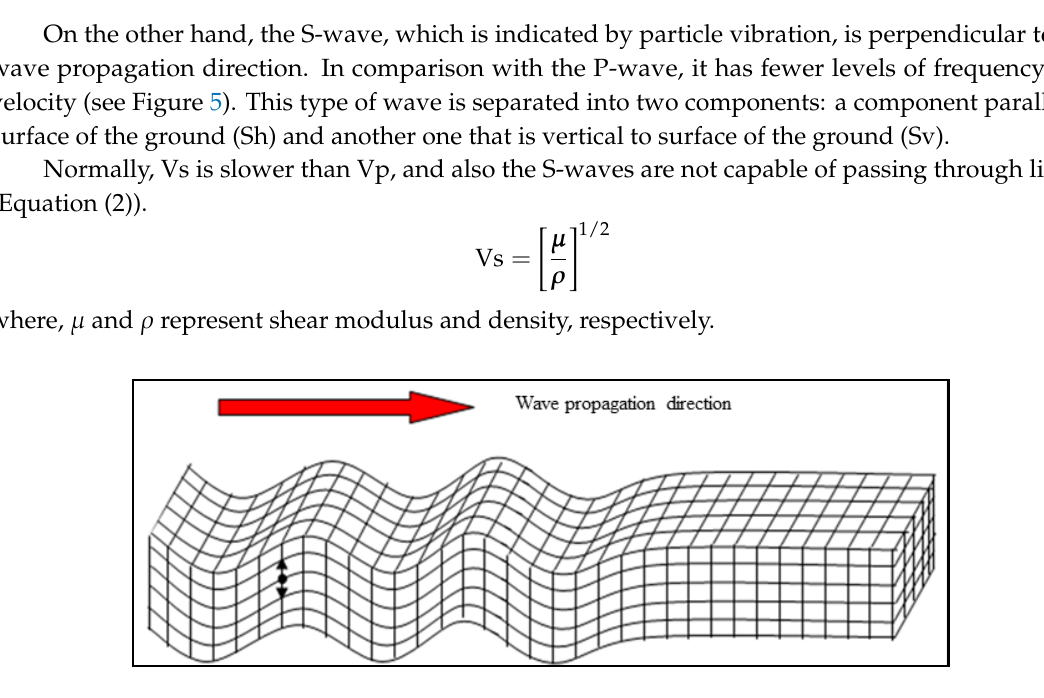
Figure 4. P-waves; particle motion, compressional and dilatation.